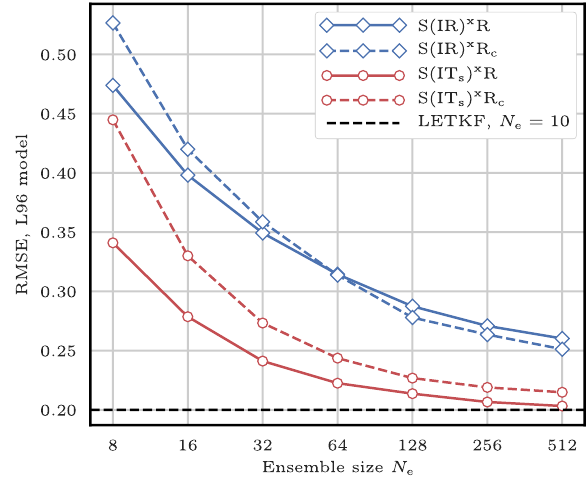
Figure 14. RMSE as a function of the ensemble size N e for the S(IR) x R, the S(IR) x R c , the S(IT R ) x R, and the S(IT R ) x R c algo- rithms.